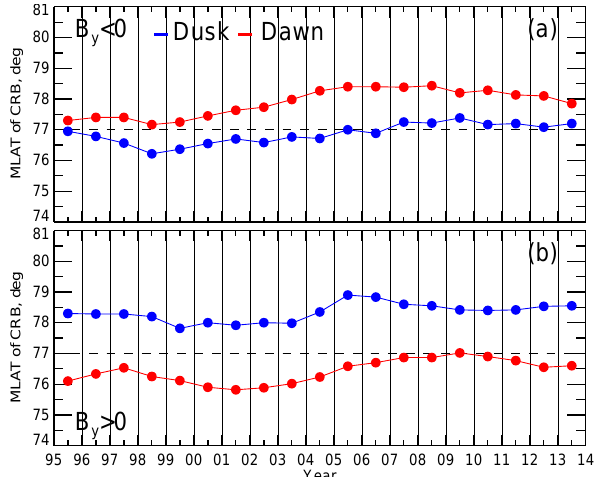
Figure 8. Magnetic latitude of the convection reversal bound- ary location (yearly medians) on the duskside (between 17:00 and 19:00MLT, blue line) and dawnside (between 05:00 and 06:00MLT, red line) for IMF B − t = [ − 4,0]nT and (a) B y < 0 and (b) B y > 0. The horizontal dashed line is the latitude of 77 ◦ given for convenience of